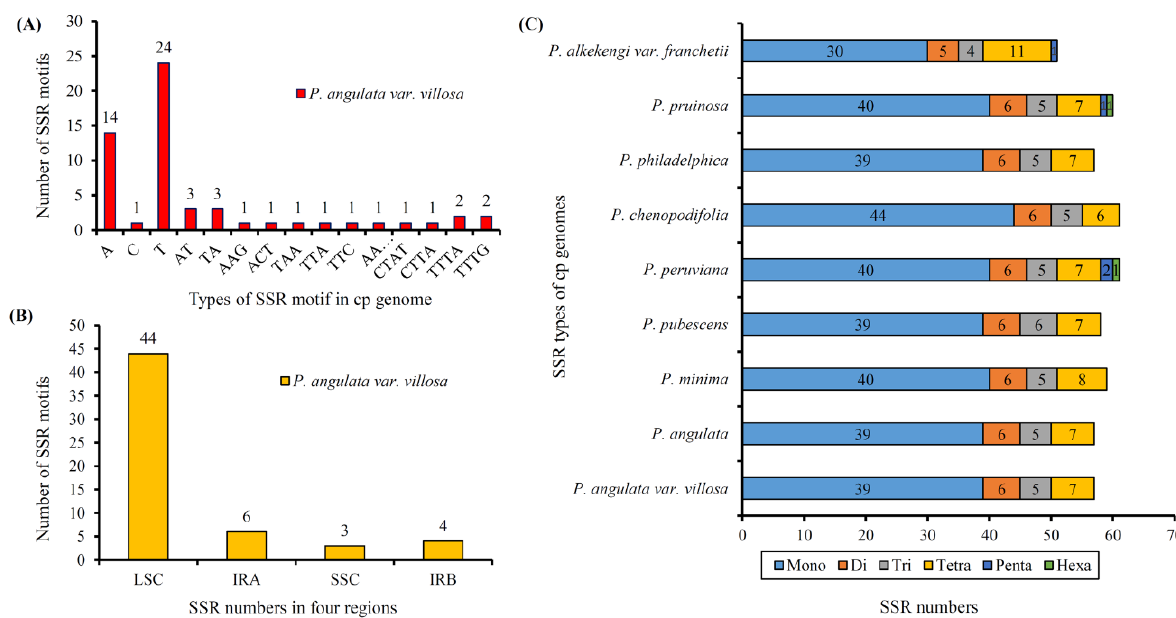
Figure 5. Simple sequence repeats (SSRs) types, distribution and presence in P. angulata var. villosa and other representative species from Physalis . ( A ), Numbers of different SSR motifs in different repeat types detected in the P. angulata var. villosa plastome. ( B ), Numbers of SSRs in different regions (IRA, IRB, LSC, and SSC) of the P. angulata var. villosa plastome. ( C ), Numbers of different SSR types detected in the genomes of the nine Physalis